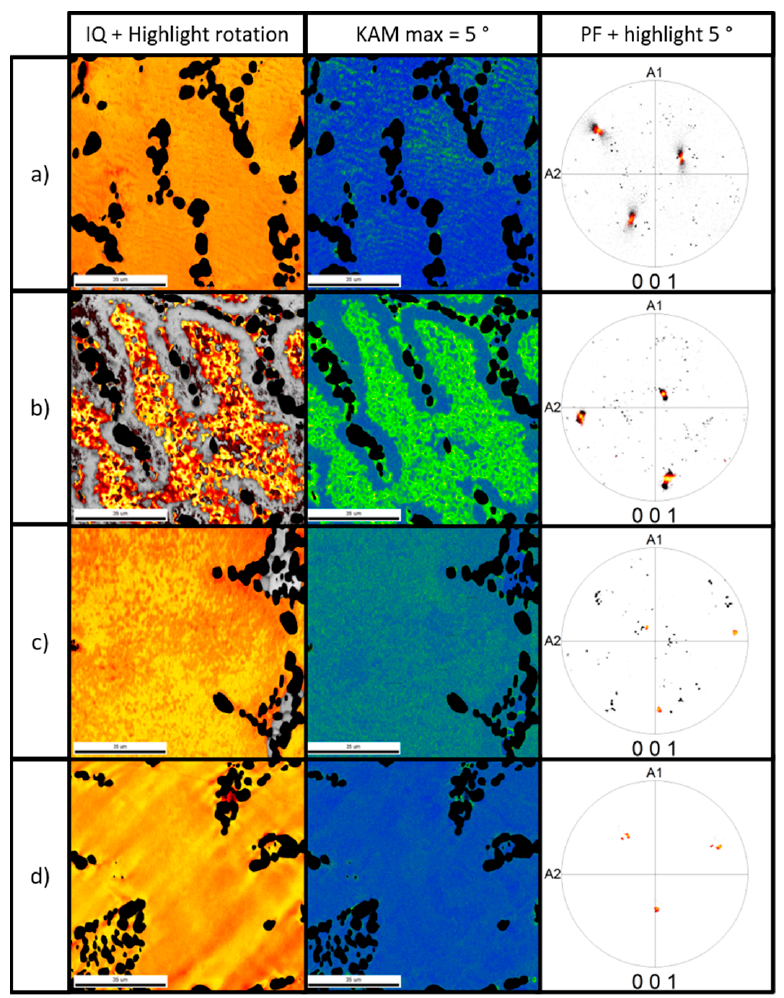
Figure 17. EBSD results: image quality, kernel average misorientation and pole figures of different material conditions: ( a ) SHT and quenched; ( b ) aged for 4 h and 5 h relaxed at 180 °C; ( c ) aged for 4 h and 5 h relaxed at 200 °C; ( d ) aged for 4 h and 5 h relaxed at 230 °C.